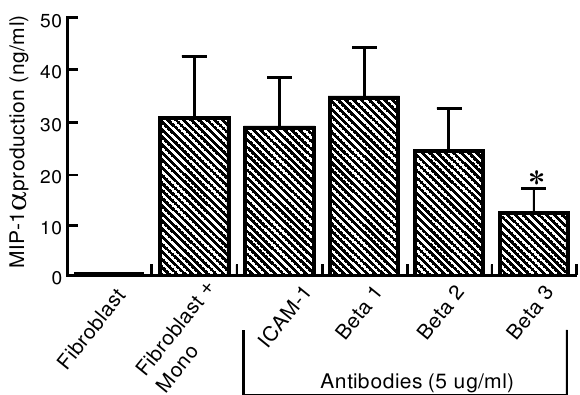
FIG. 5. Adhesion pathways mediated production of MIP-1 a during fibroblast–monocyte interaction. Monoclonal anti- bodies to specific adhesion molecules or integrins were added to fibroblast–monocyte co-culture at time 0 at a concentration of 5 m g/ml. After 24h of co-culture the culture supernatant was harvested and MIP-1 a was measured using a specific ELISA. Data represents mean ± SE of three repeat experiments. Significant decreases in MIP-1 a were observed only in cultures treated with anti- b 3-integrin. * P <0.05.